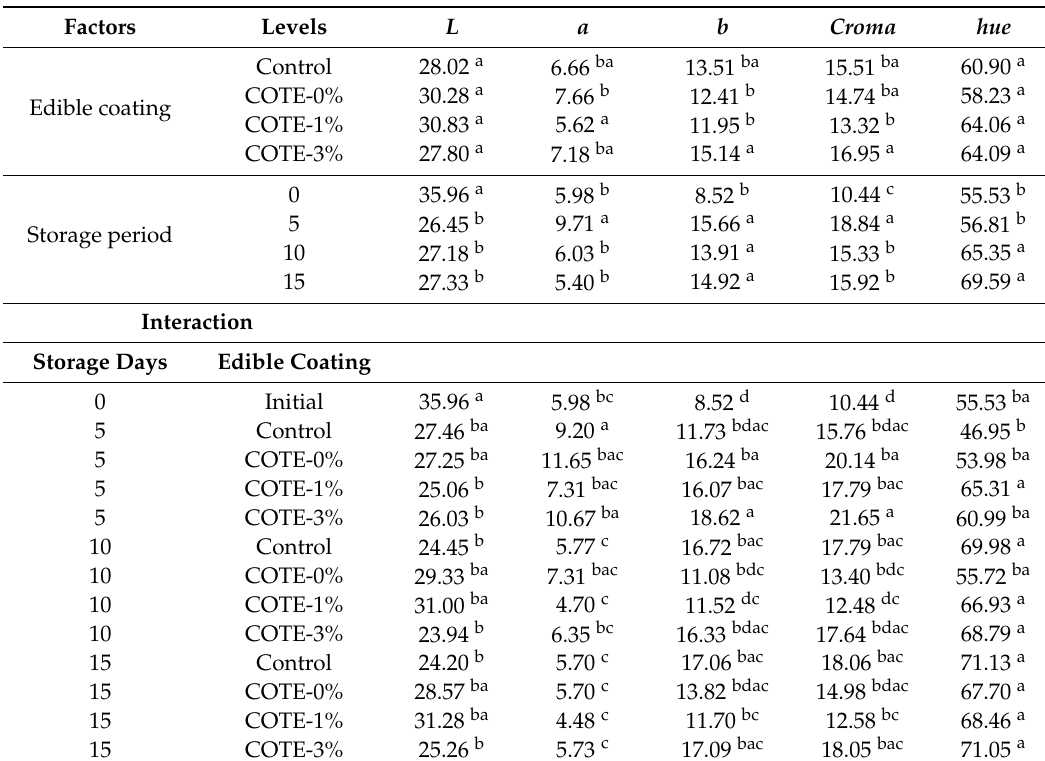
Table 2. Effect of edible coating incorporated with tomato oily extract and storage period on color of Myrtillocactus geometrizans fruits during